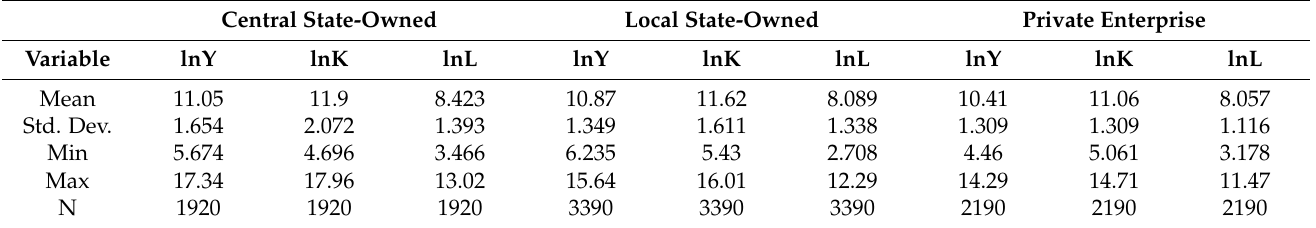
Table 1. Descriptive statistics of relevant indicators of listed enterprises with three kinds of ownership.